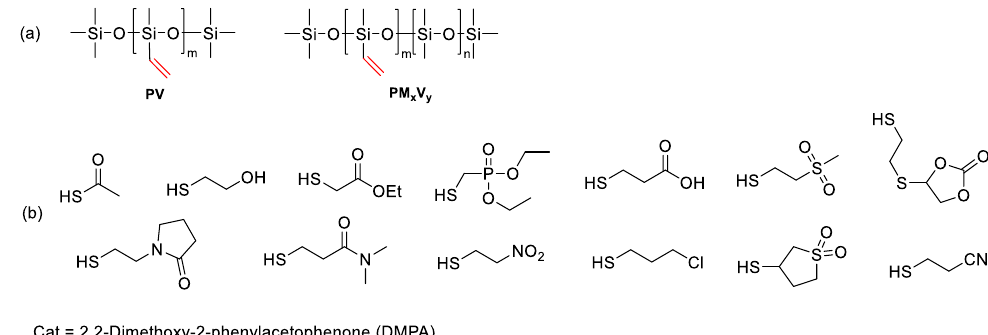
Figure 32. Structures of the Starting Polysiloxanes PV and PM x V y ( a ) and of Polar Thiols Selected for Their Functionalization ( b ).